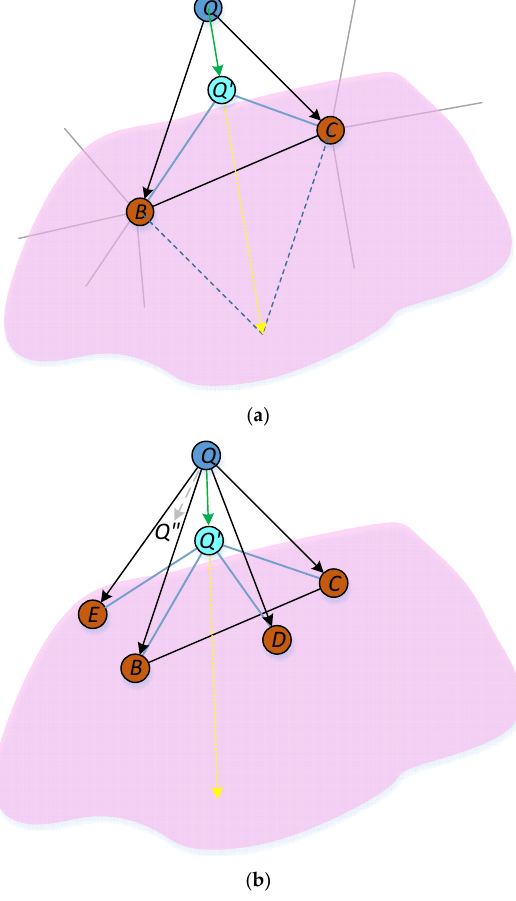
Figure 3. Moving direction of a position-adjusting sensor. ( a ) The MDT determines a sensor’s moving direction according to the vectors to the other two sensors of the same triangle, which is constructed by the Delaunay triangulation architecture. ( b ) The MCH determines a sensor’s moving direction according to the vectors of all neighboring sensors that have a different set of convex hull. In MCH, all the sensors in sets Ψ ic’ and Ψ oc’ are settled at both sides of the continuous object’s boundary. MCH only selects them to adjust the positions instead of all nodes in Ψ ic and Ψ oc . This choice can efficiently reduce the number of moving sensors. Considering